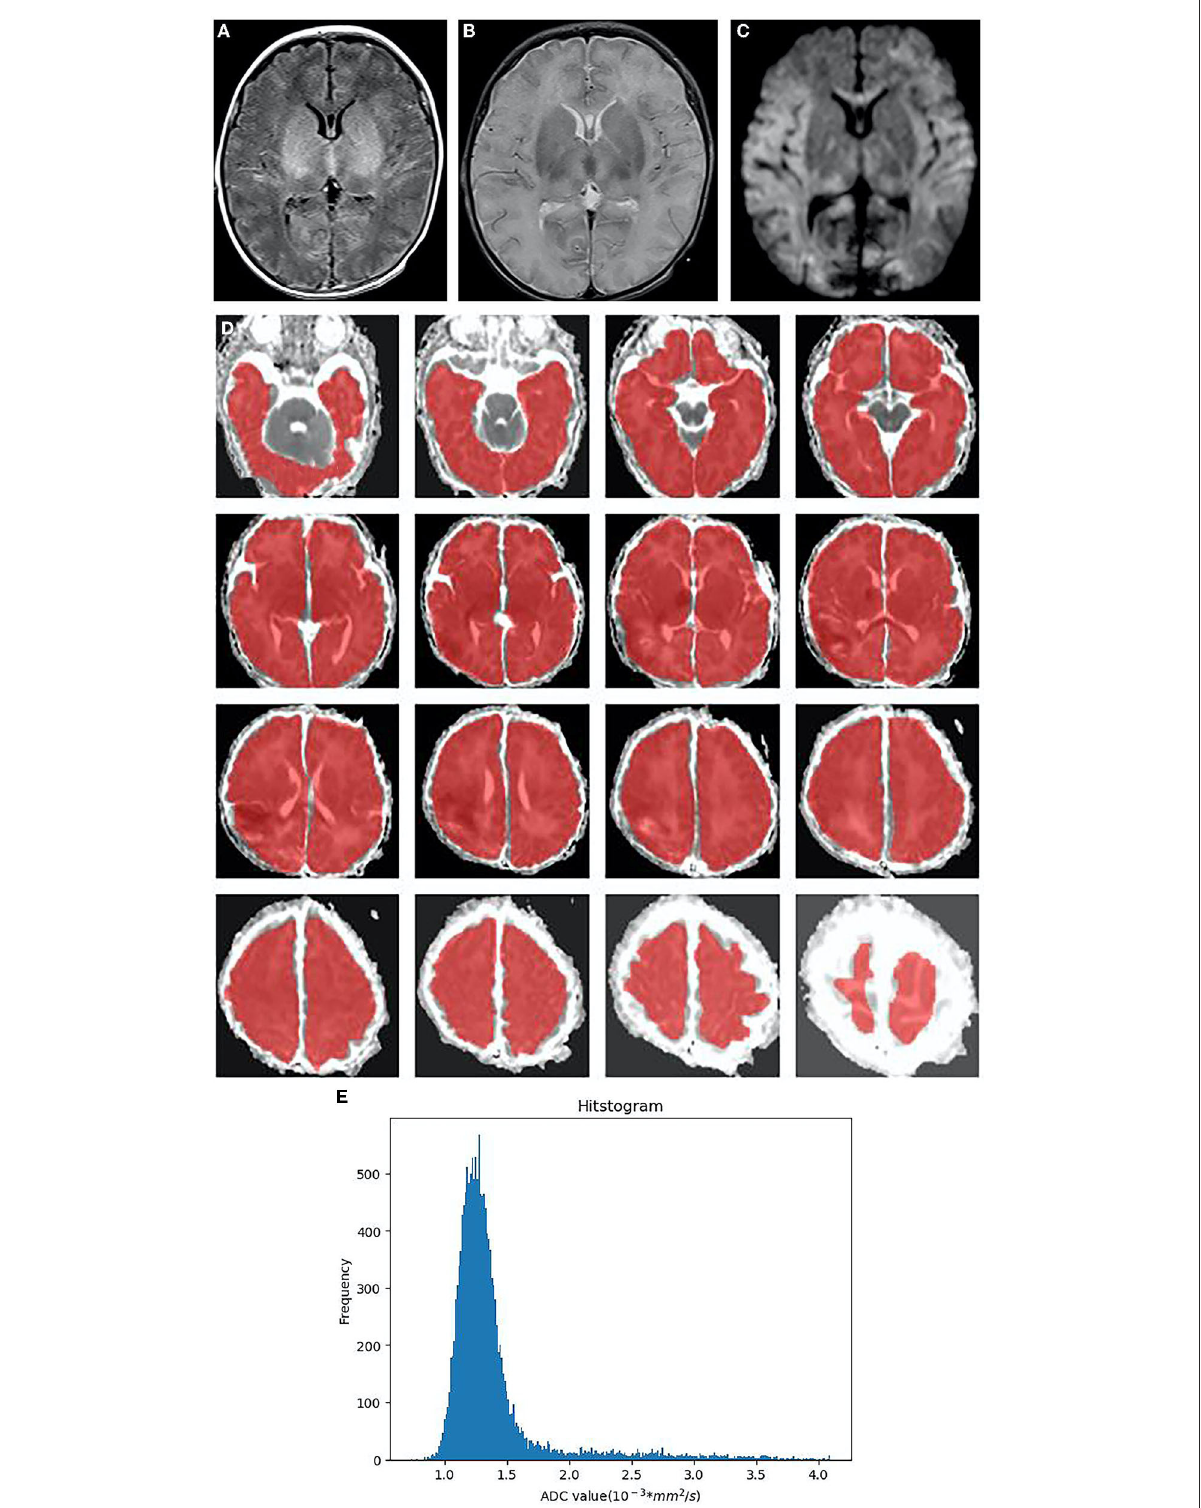
FIGURE3 Neonatal with HIE, moderate-to-severe group, male, 4 days old. (A) :T1WI sequence, the blurred boundary between gray and white matter in bilateral frontal, temporal lobes, and occipital lobes, the decreased signal in white matter, the increased signal in the thalamus and basal